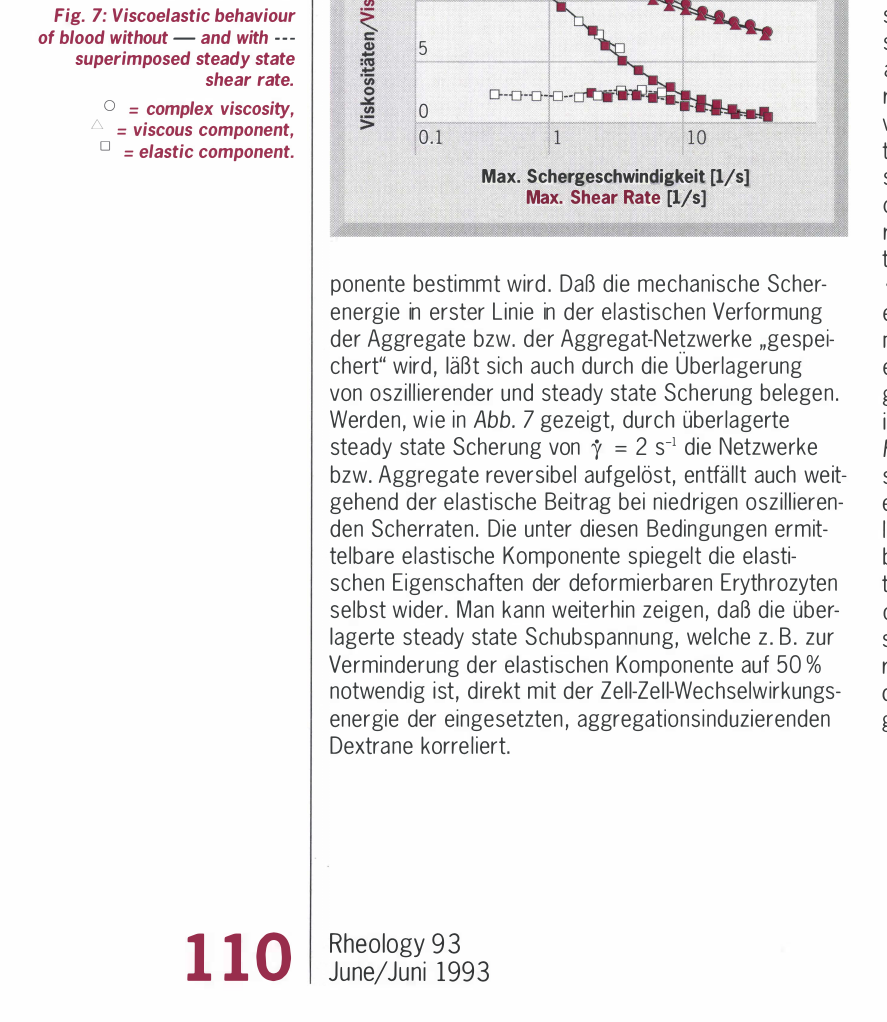
Abb. 7: Viskoelastisches Verhalten von Blut ohne - und mit---iiberlagerter steady state Schergeschwindigkeit